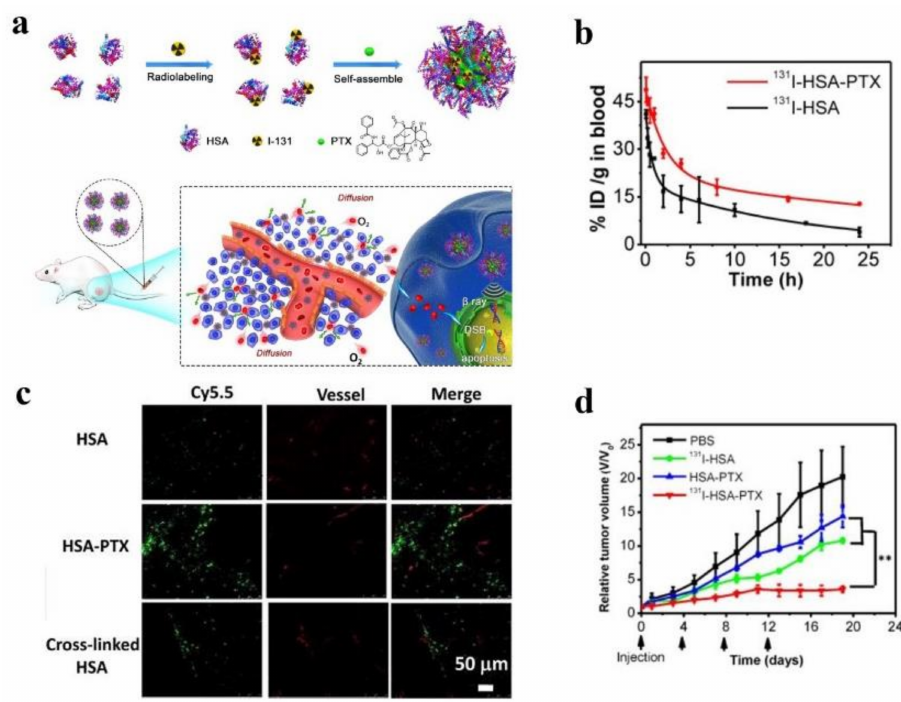
Figure 3. ( a ) A schematic illustration to show the preparation of 131 I-HSA-PTX nanoparticles for in vivo combined chemo-RIT; ( b ) The blood circulation profiles of 131 I-HSA and 131 I-HSA-PT; ( c ) Confocal fluorescence micrographs of tumor slices collected from mice injected with Cy5.5-labeled HSA, HSA-PTX or cross-linked HSA. The red signals were from the fluorescence of anti-CD31-stained blood vessels; ( d ) Tumor growth curves of mice with different treatments given at day 0, 4, 8 and 12; reproduced with the permission from [106], Copyright (2017) Ivyspring International